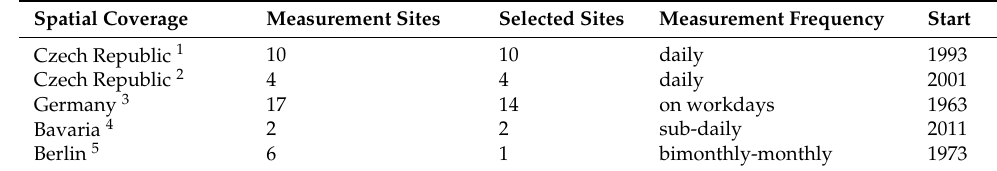
Table 1. Suspended sediment data in the Elbe basin. Sources: (1) International Commission